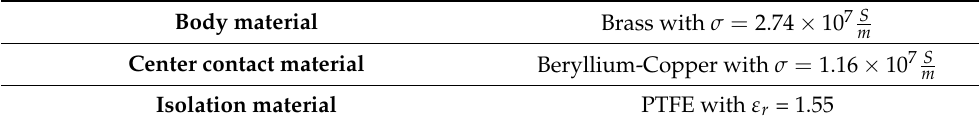
Table 2. Material parameters used for the SMA edge mount connector [3].